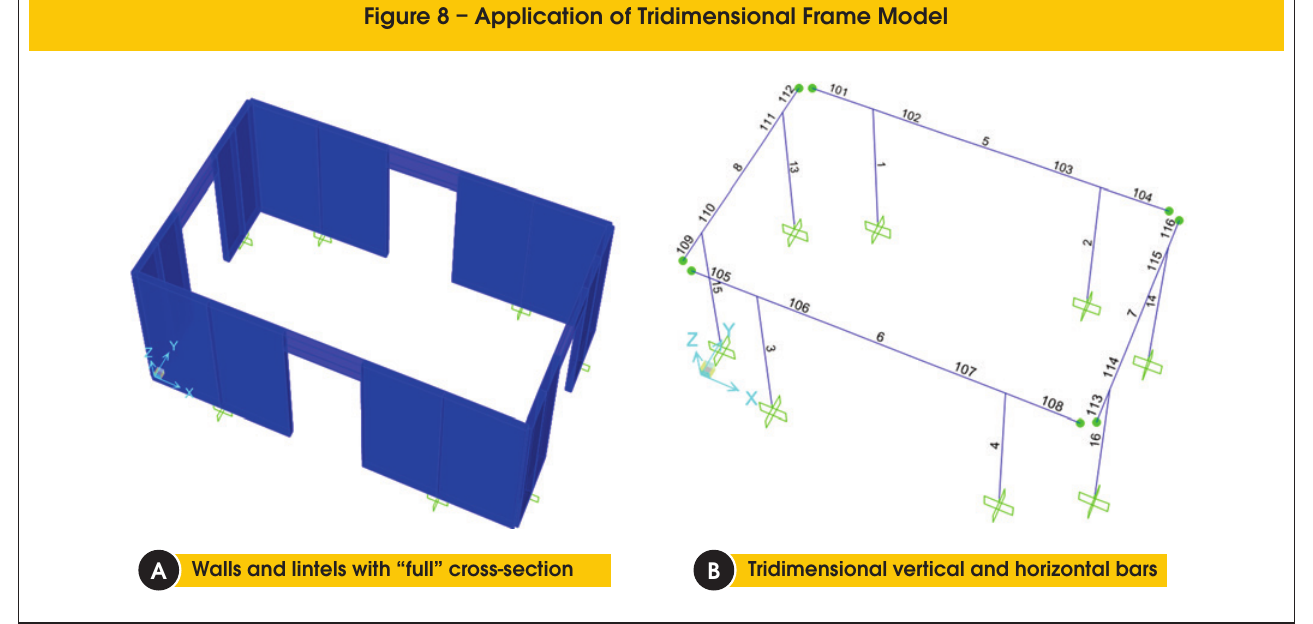
Figure 8 – Application of Tridimensional Frame